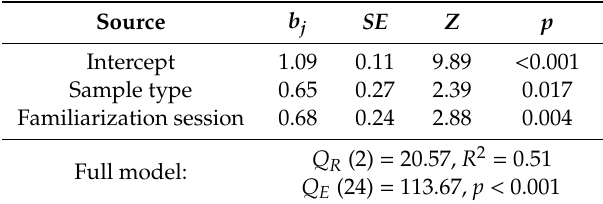
Table 5. Results of the multiple meta-regression model assuming a mixed-e ff ects model.